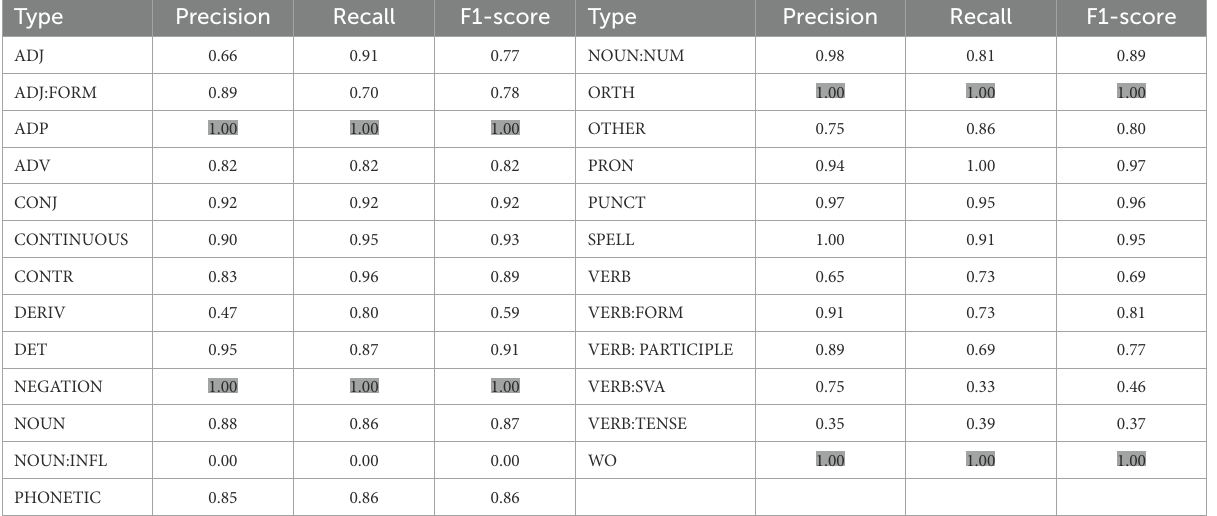
TABLE 6 Annotation performance on each error type.